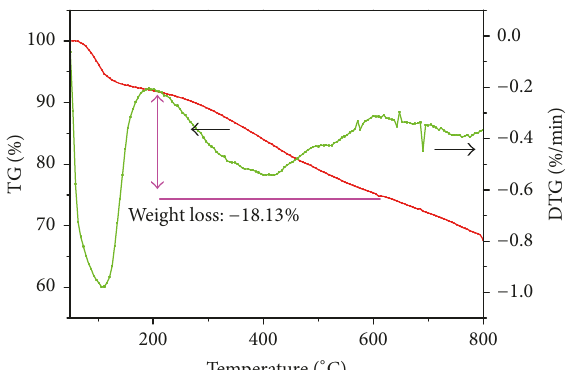
Figure 3: TG spectra of Pd/C-OH − .